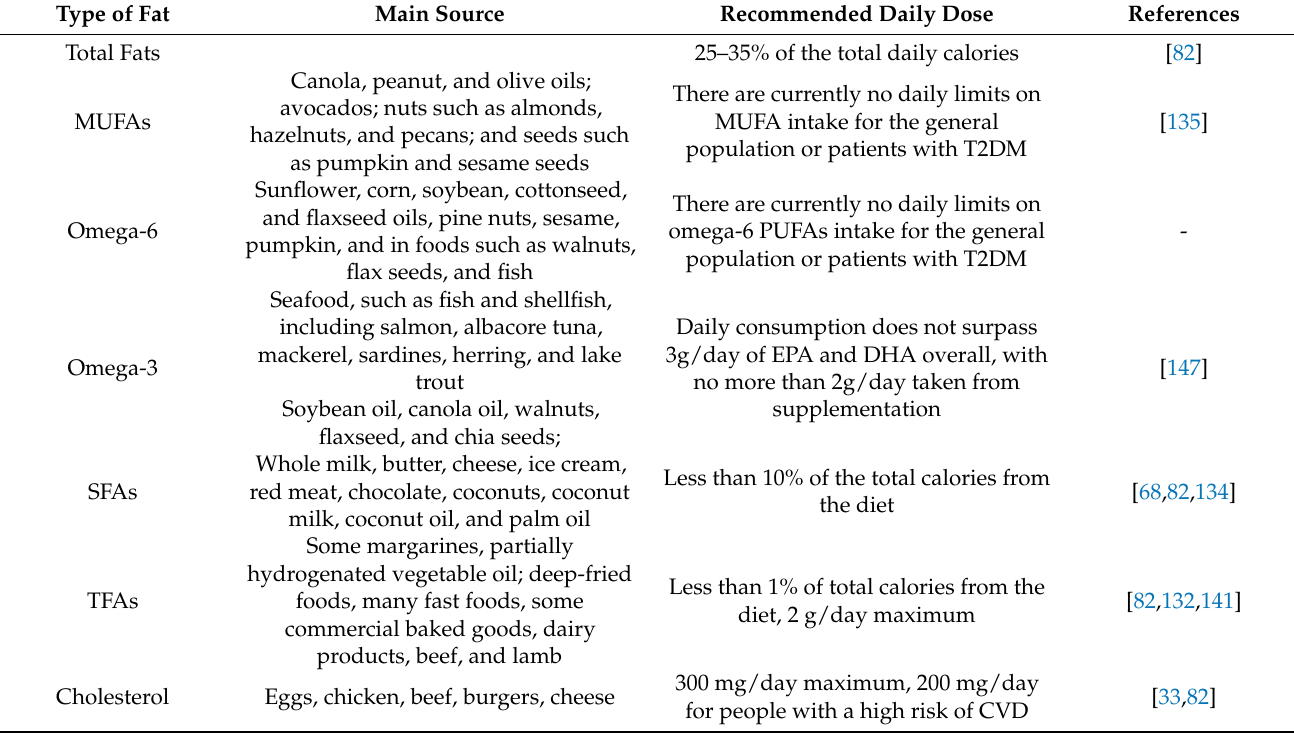
Table 2. Recommendation regarding dietary fat intake for patients with